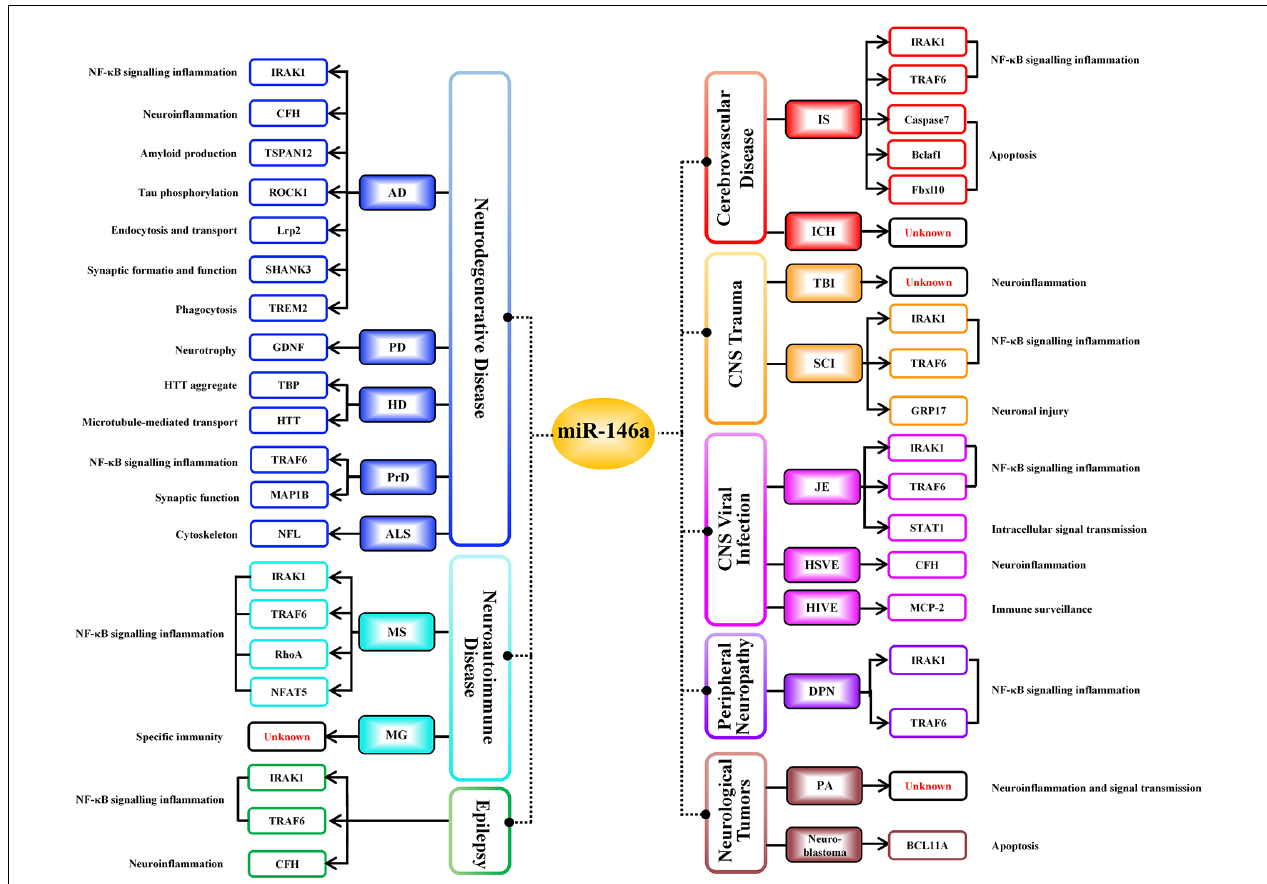
FIGURE 3 | Negative regulatory targets of miR-146a in various neurological diseases. Different target genes of miR-146a have been identified in distinct neurological diseases; miR-146a negatively regulates all targeted downstream genes shown in this figure, ultimately influencing the progression of neurological